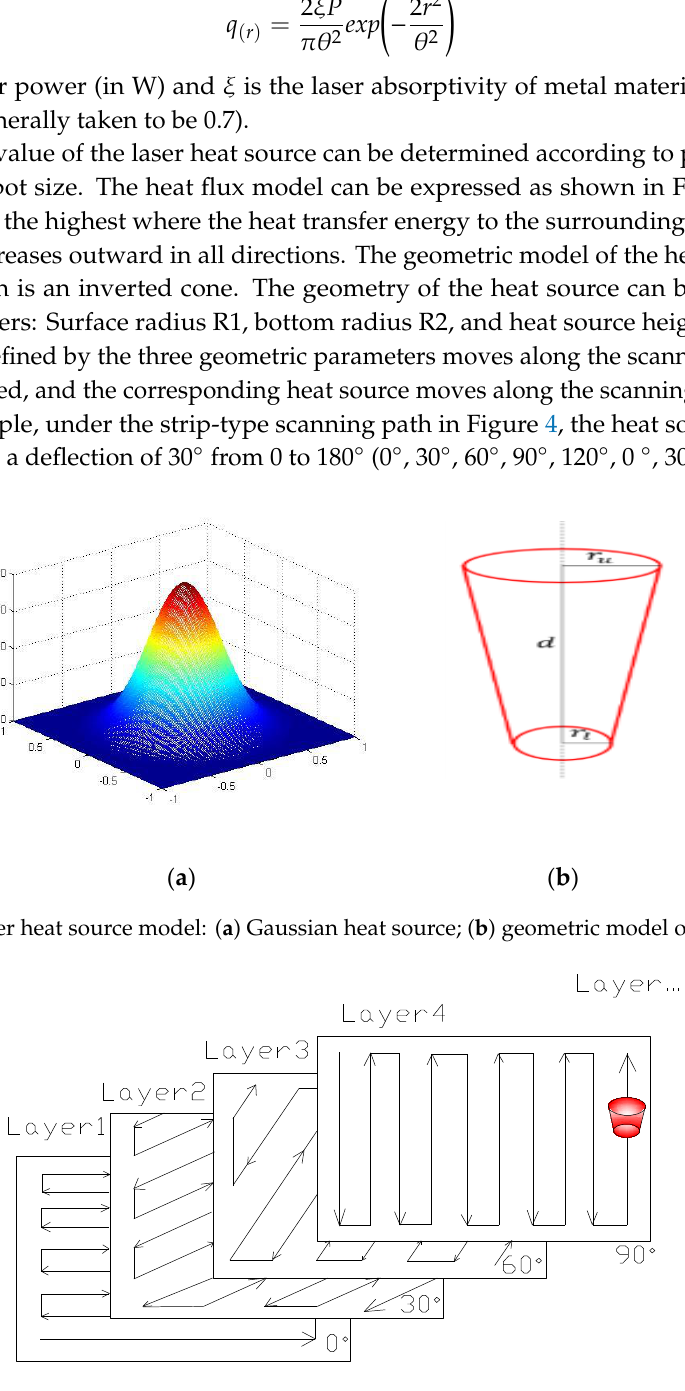
Figure 4. The laser scanning path of layer by layer.